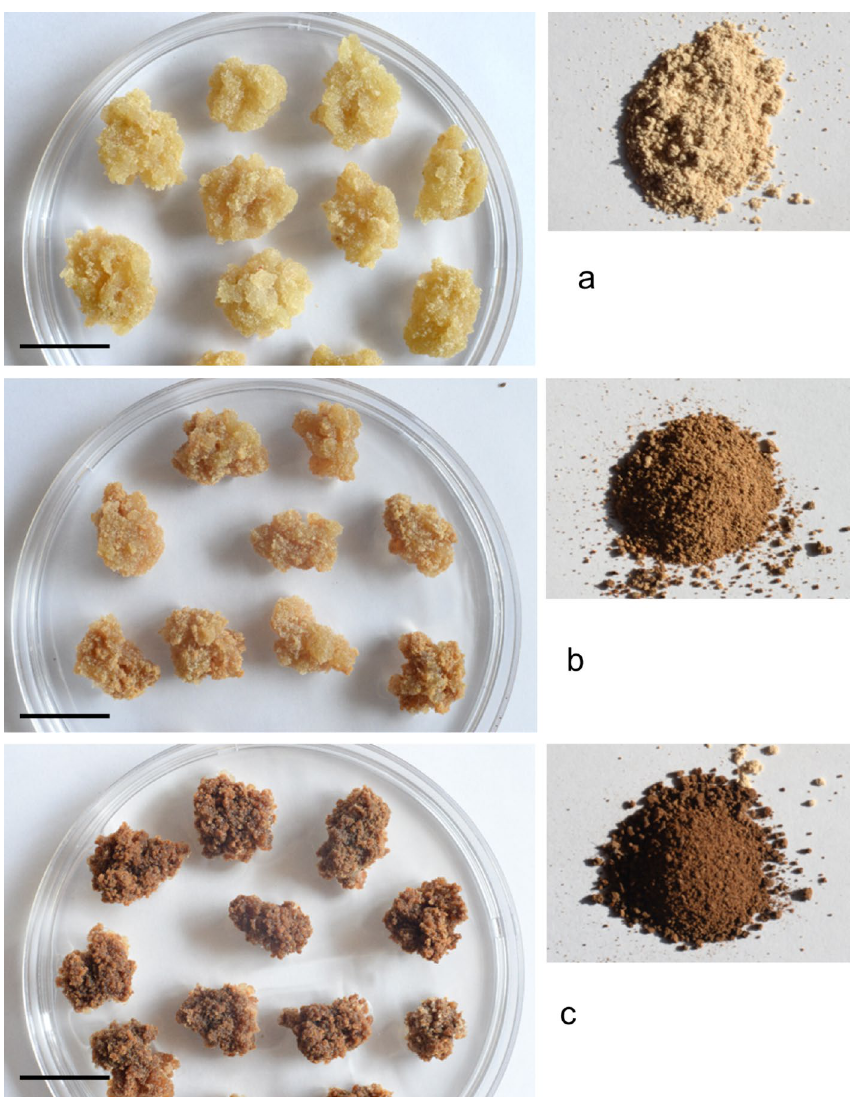
Figure 3. Photos of callus its ground powders after drying. ( a ) Faded yellow callus after one month of culture on 1/2 LV medium with 1.0 mg/L 2,4-D with 0.5 mg/L BA. ( b ) Brown callus after 8 weeks of culture on 1/2 LV medium with 1.0 mg/L 2,4-D with 0.5 mg/L BA. ( c ) Dark brown callus after 12 weeks of culture on 1/2 LV medium with 1.0 mg/L 2,4-D with 0.5 mg/L BA. Photos on the right sides ( a–c ) are ground powders after drying. Bars in ( a–c ) = 20